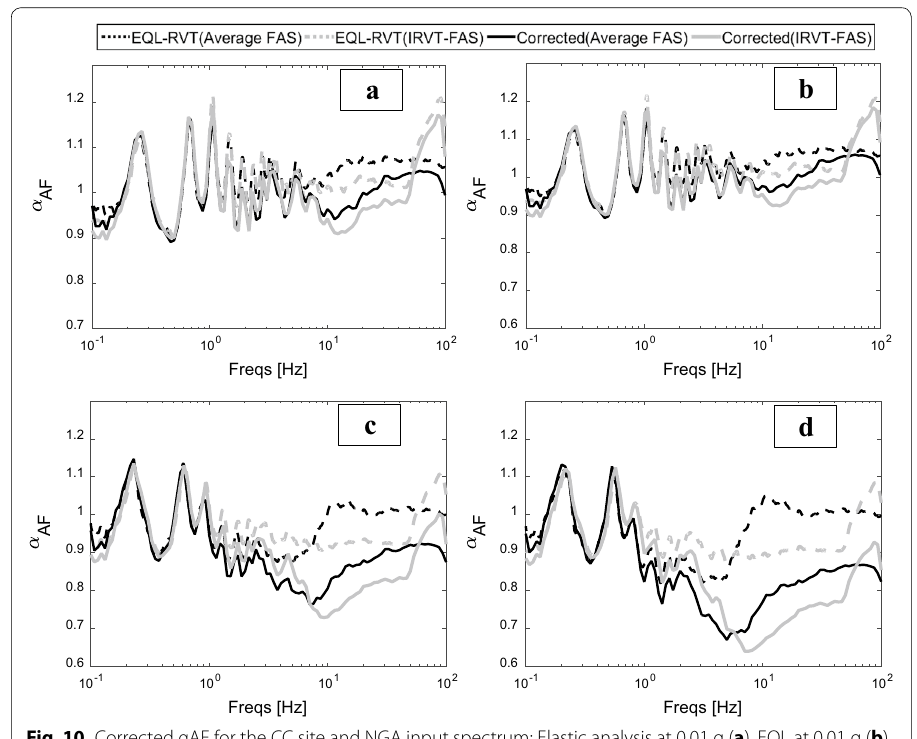
Fig. 10 Corrected αAF for the CC site and NGA input spectrum: Elastic analysis at 0.01 g ( a ), EQL at 0.01 g ( b ), EQL at 0.3 g ( c ) and EQL at 0.6 g ( d